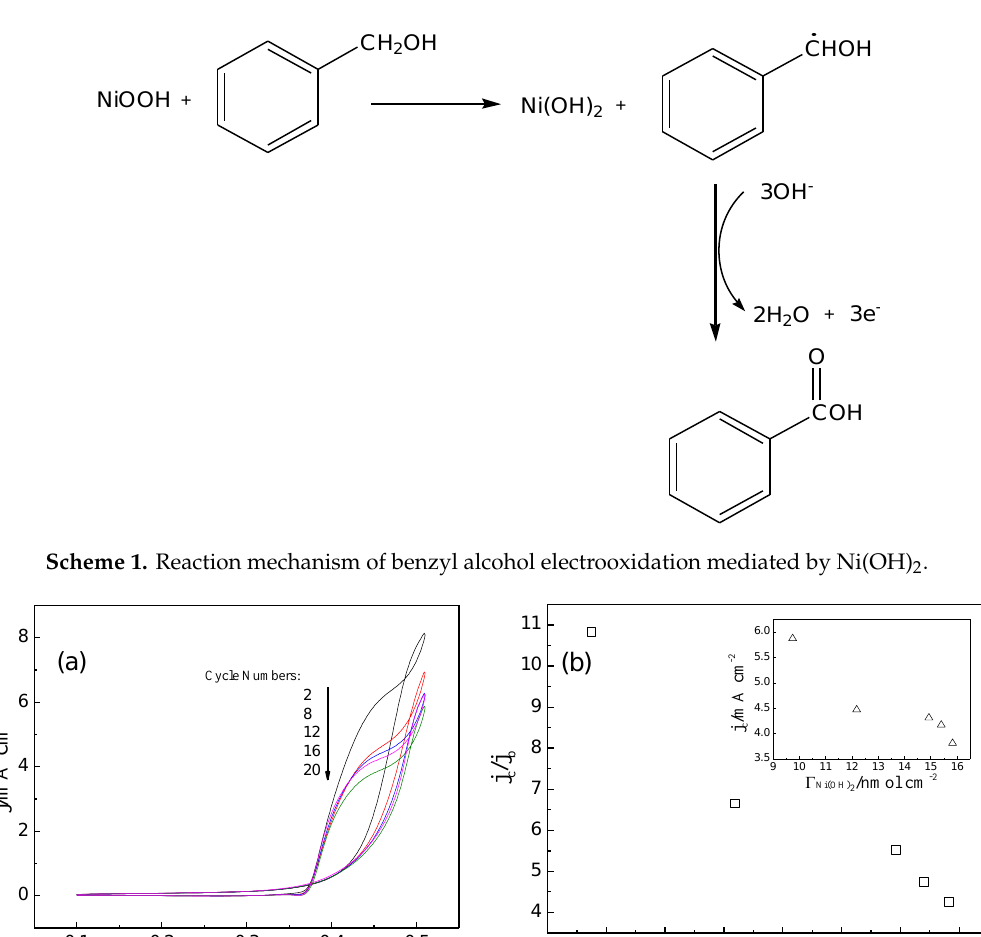
Scheme 1. Reaction mechanism of benzyl alcohol electrooxidation mediated by Ni(OH) 2 .